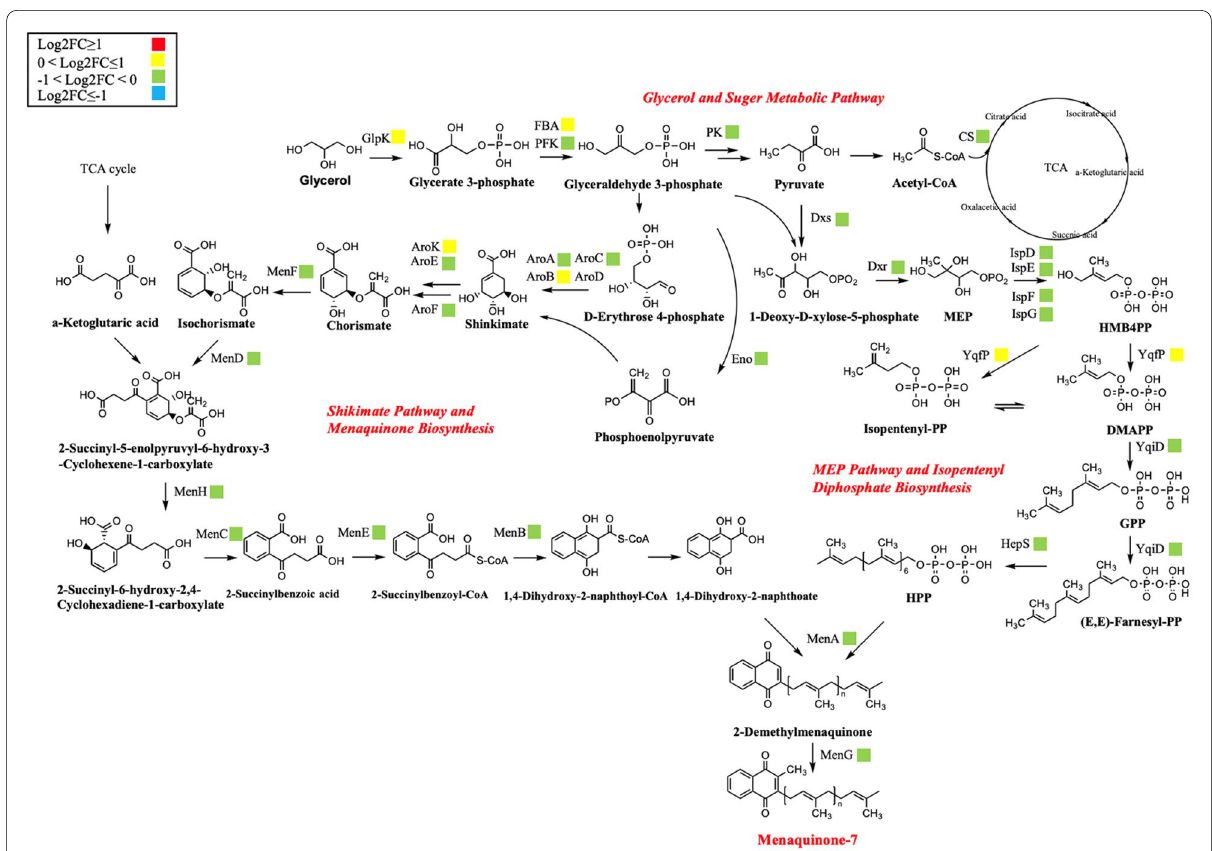
Fig. 5 Changes in transcript abundance of genes involved in menaquinone-7 metabolic pathway in